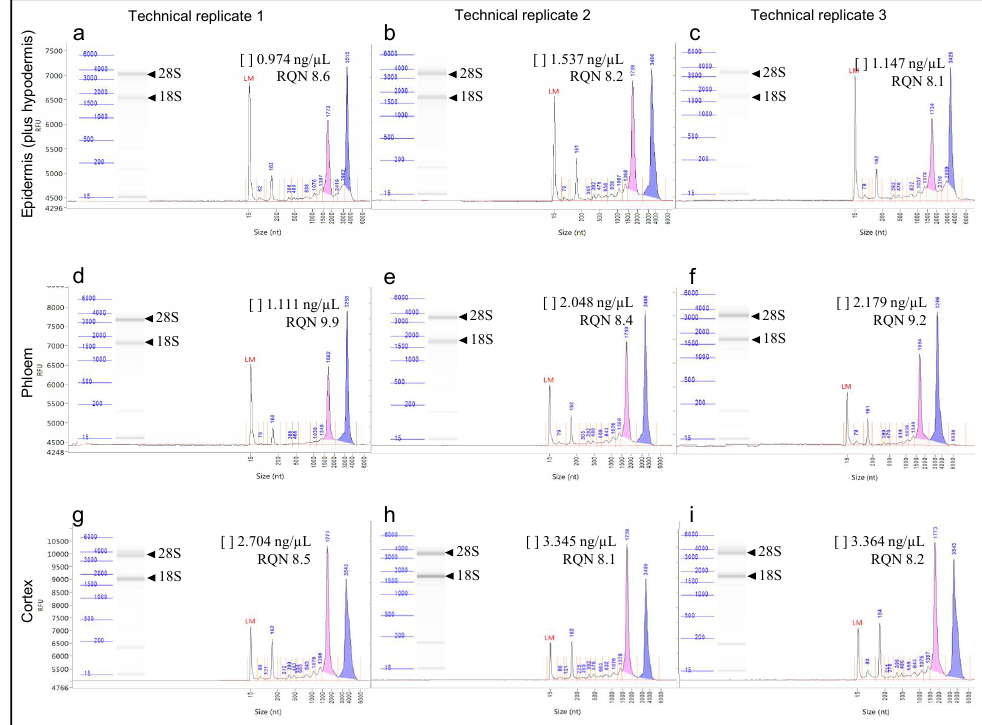
Figure 4. Integrity of the total RNA isolated after microdissection of the epidermis (plus hypodermis) ( a – c ), phloem ( d – f ) and cortex ( g – i ) from stem-base tissue cryosections, using the Fragment Analyzer system. The three graphics for each tissue corresponds to three technical replicates. The results are shown as an electropherogram showing two peaks and a digital gel showing two bands corresponding to the two ribosomal RNA subunits (18SrRNA and 28SrRNA). The concentration ([ ]) for each RNA sample is indicated as well as the corresponding RNA Quality Number